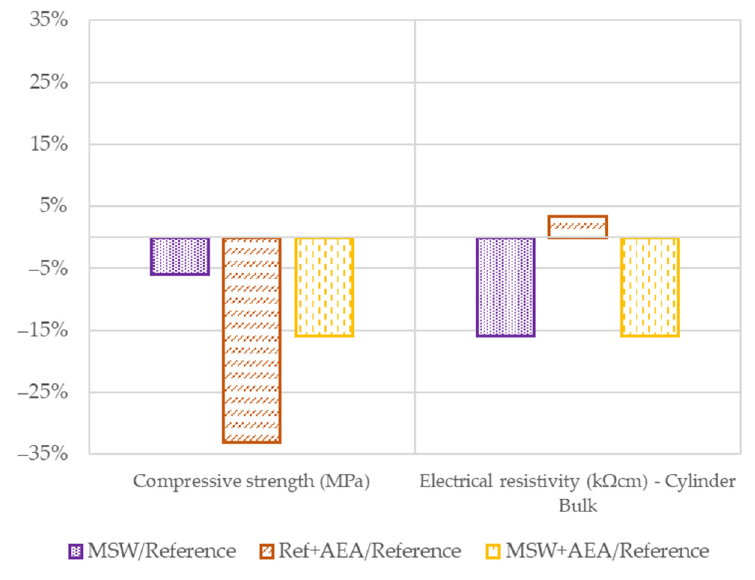
Figure 6. Relative results in 91 days.